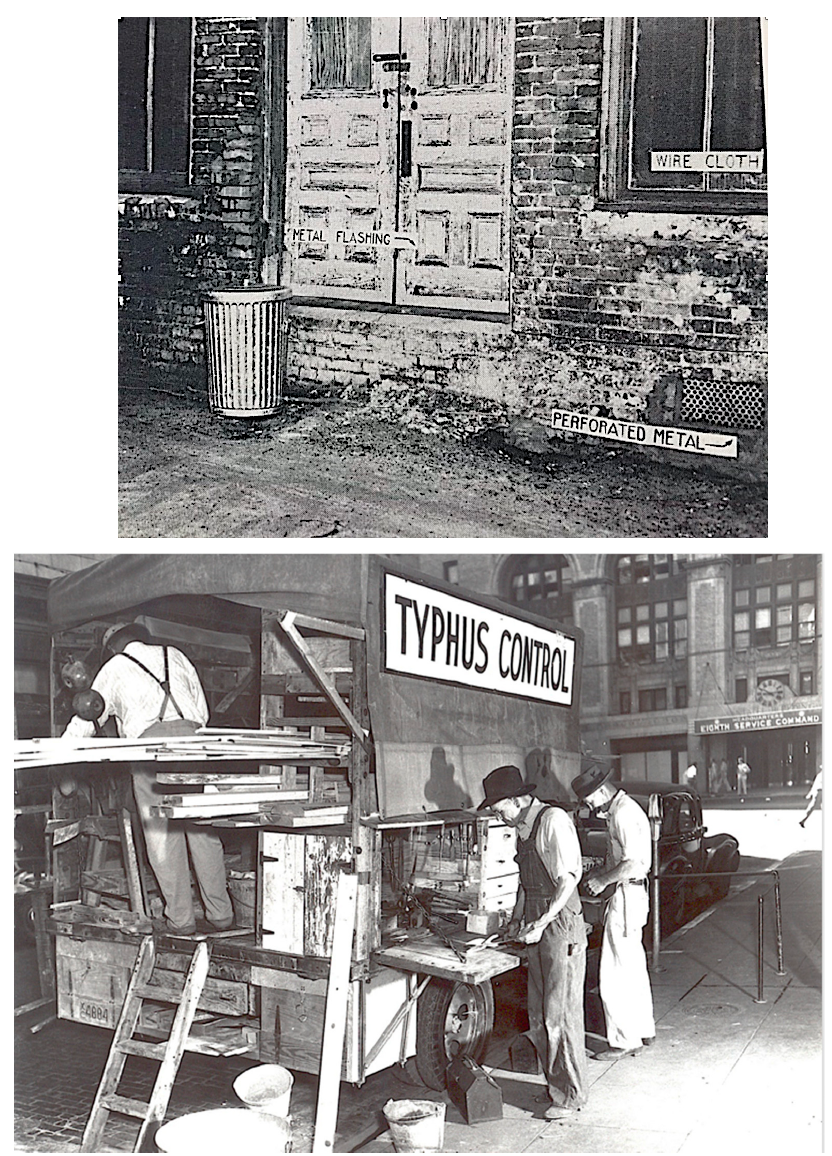
Figure 8. ( upper ) Entrance portals for rats blocked by vent stoppage: metal flashing around edge of a wooden door, screening for a window, and a perforated metal grate [156]. ( lower ) Men involved in vent stoppage against rats in San Antonio, TX, likely late 1930s/early 1940s.